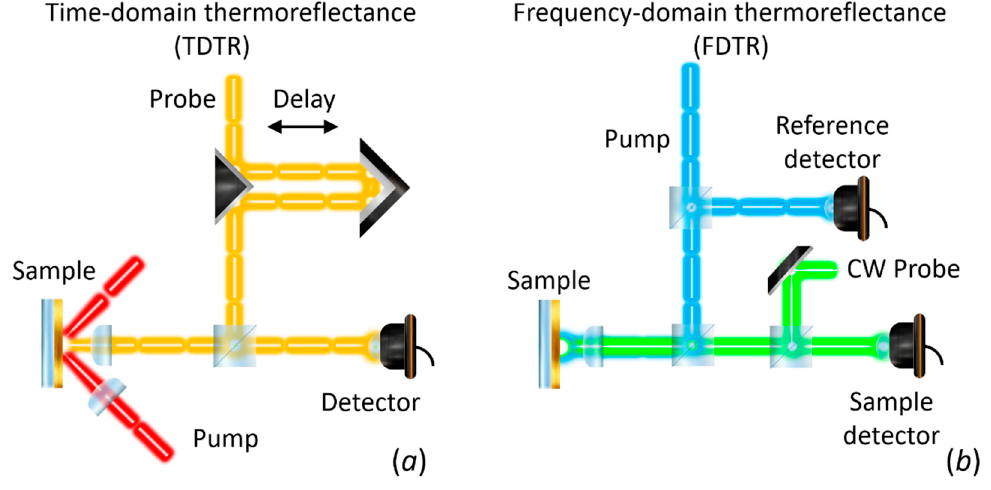
Figure 9. Schematic representation of thermoreflectance-based methods. ( a ) Time-domain and ( b ) frequency-domain thermoreflectance techniques. Adapted from (Paddock) [197] and (Schmidt) [199].